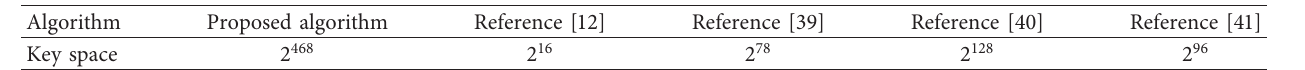
Figure 12: Key sensitivity analysis: (a) initial value change of 10 − 14 , (b) initial value change of 10 − 15 , and (c) initial value change of 10 − 16 Table 9: Comparison of key spaces.